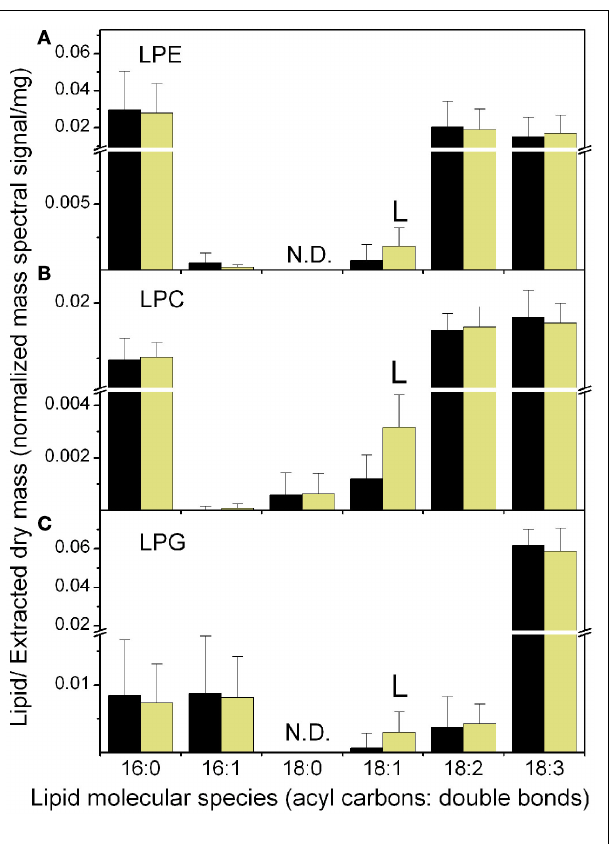
FIGURE 4 | Lysophospholipid molecular species at the end of the dark and light periods. The data are from Experiment 1. (A) LPE, (B) LPC, (C) LPG.The black bars represent the levels at the end of the dark period and the light yellow bars represent the levels at the end of the light period.The “L” symbol indicates that the amount of normalized mass spectral signal per extracted dry mass was significantly higher ( p < 0.05) at the end of the light period than at the end of the dark period. N.D. indicates that LPE 18:0 and LPG 18:0 were not determined. n = 20 for dark; n = 19 for light. Note the break in the y -axis and the change in scales above and below the